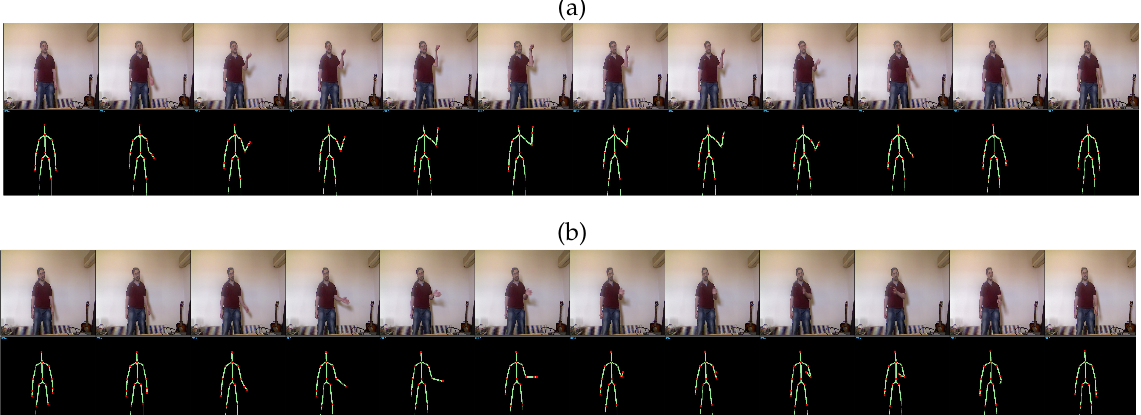
Figure 2. Aligned RGB and skeletal images of ( a ) swipe-up and ( b ) swipe-in gestures, performed by the same